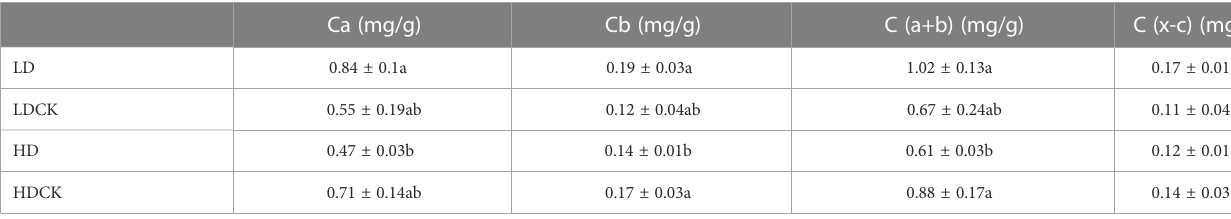
TABLE 2 Photosynthetic pigments content in foxtail millet leaves under drought stress relating to yield formation stage.